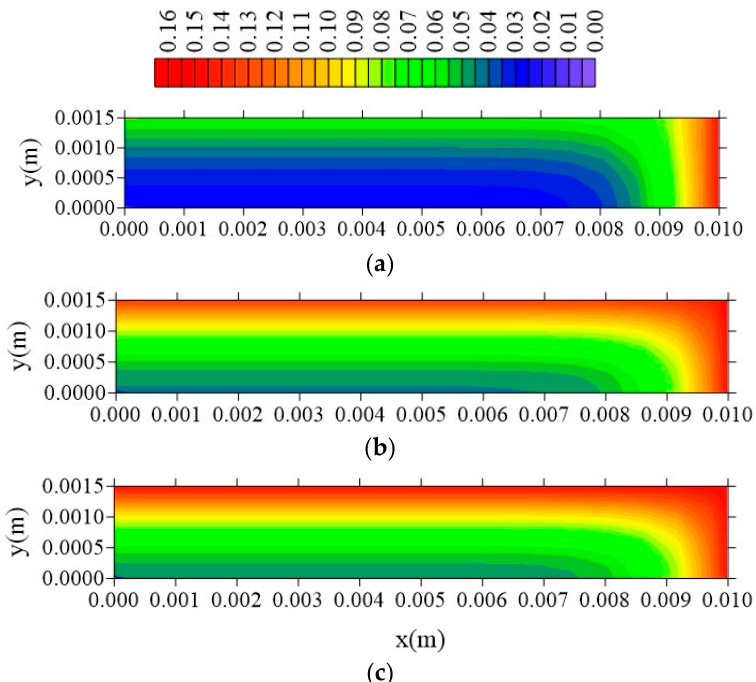
Figure 25. Distribution of free solute concentration (C in kg/kg) in plan z = R z /2 for different distances l y (t = 211 h, Cases 9, 11, and 12). In which ( a ) l y = 0.001 m; l x = 0.1 m and l z = 0.1 m ; ( b ) l y = 0.01 m;